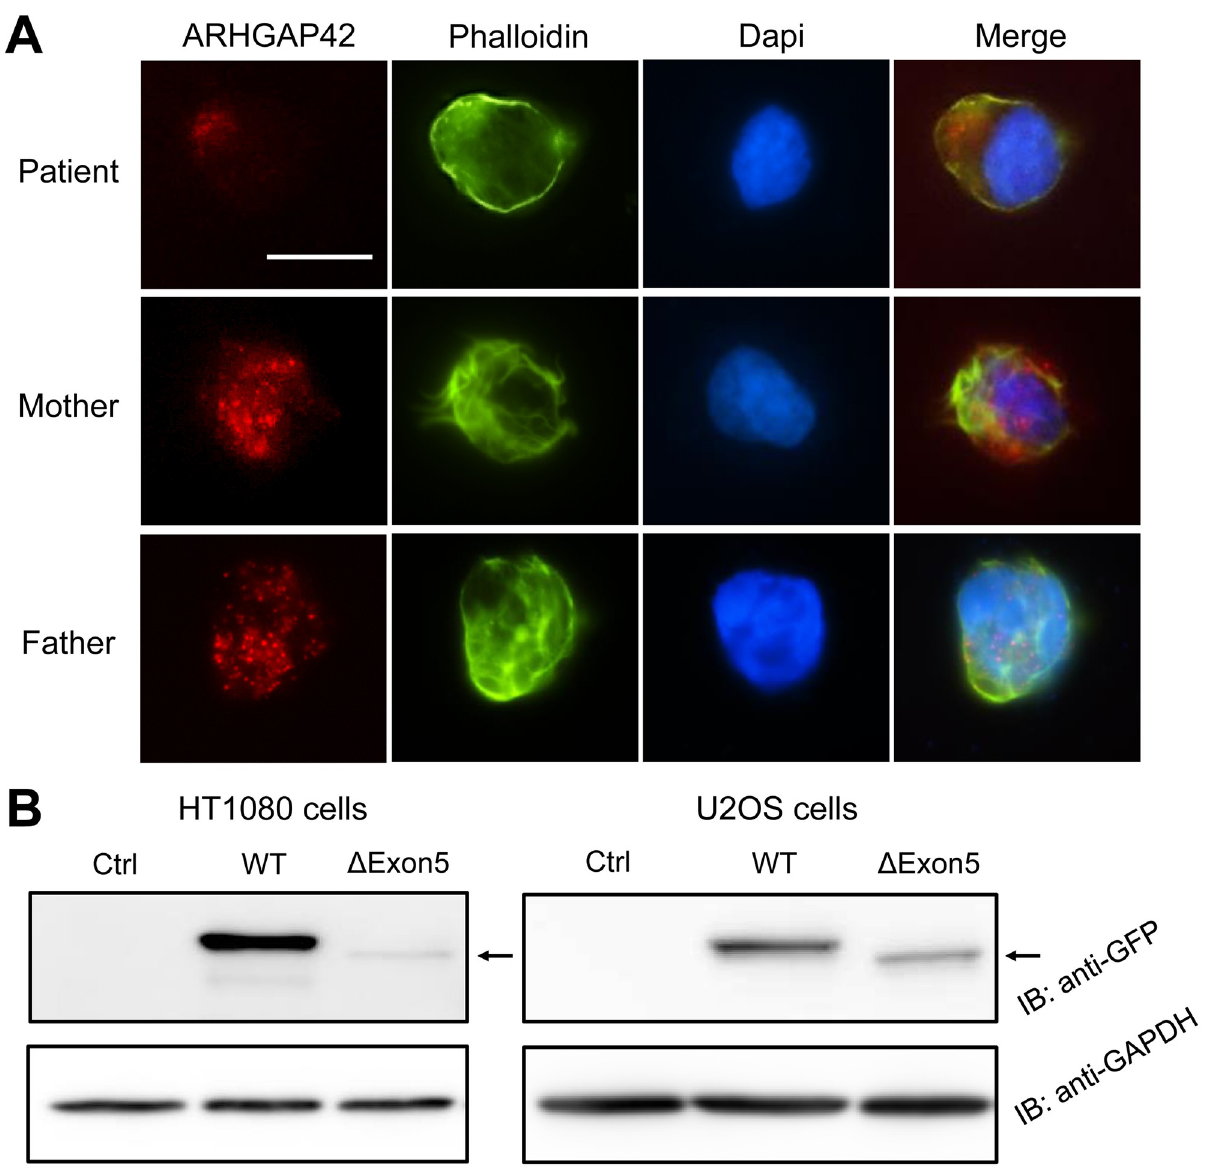
Fig 4. ARHGAP42 stop-gain variant causes reduced ARHGAP42 expression. (A) Immunofluorescence of ARHGAP42 in the patient and her parents lymphoblastoid cells. Lymphoblastoid cells were fixed, permeabilized, and stained with DAPI (blue), phalloidin (green), and ARHGAP42 (red) (scale bar 10 μ m); (B) Expression of control, GFP-ARHGAP42 WT and GFP-ARHGAP42 Δ Exon5 in transfected HT1080 and U2OS cells by immunoblotting (black arrow indicates a lower level of ARHGAP42 Δ Exon5